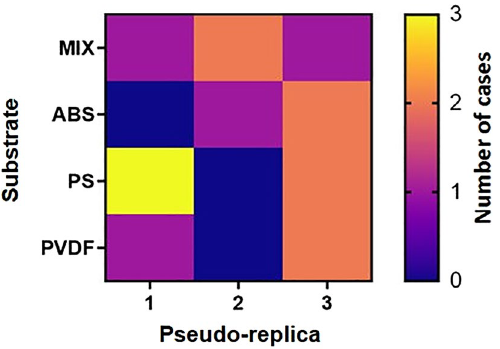
Figure 6. Heat map with the number of artificial cases rebuilt by caddisflies in each substrate for the three pseudo-replicas. Replica no. 1 indicate the first time of exposure. MIX = natural substrate and lMP (50% each); ABS = acrylonitrile butadiene styrene; PS = polystyrene; PVDF = polyvinylidene fluoride. The image is obtained by the software GraphPad Prism (ver. 8.4.2, https ://www.graph pad.com/suppo rt/faq/prism -842-relea se-notes /).